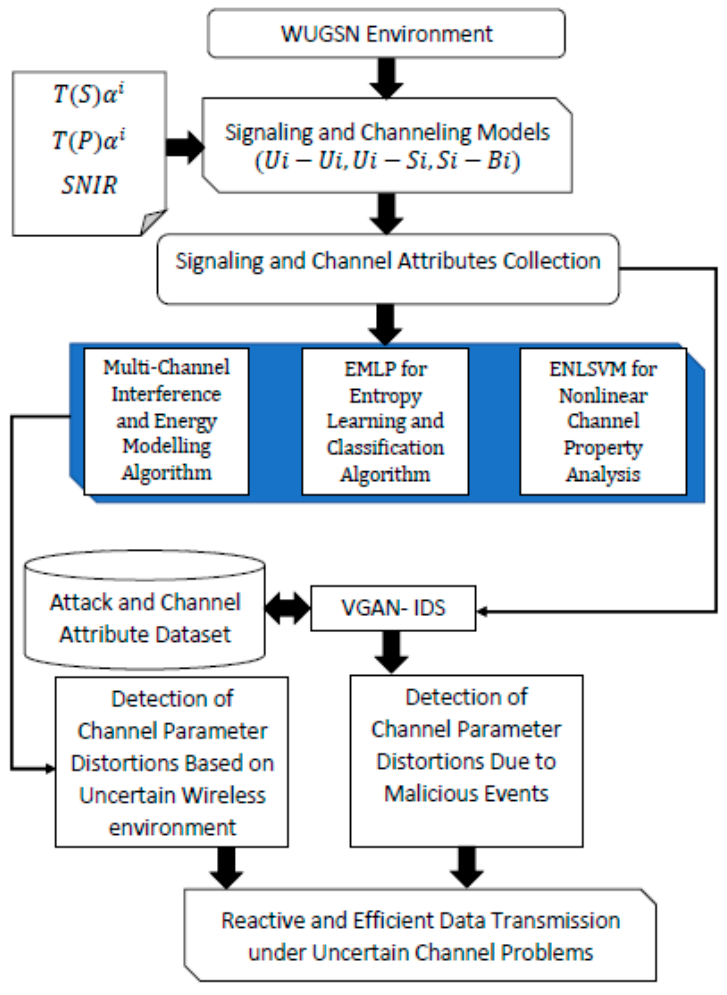
Figure 4. System design of proposed DMCAP phases .